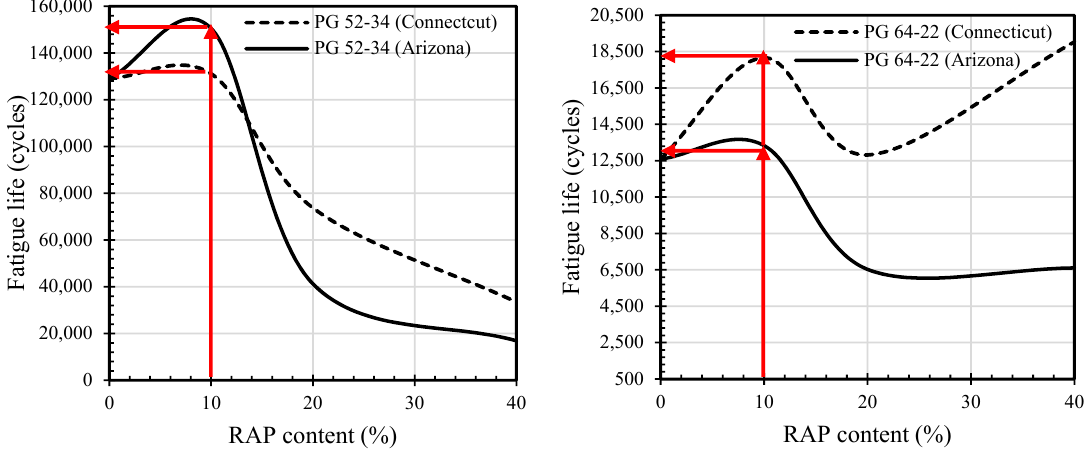
Figure 2. Correlation of fatigue life and RAP content which is based on flexural fatigue tests based on data reported by Hajj et al. [19].